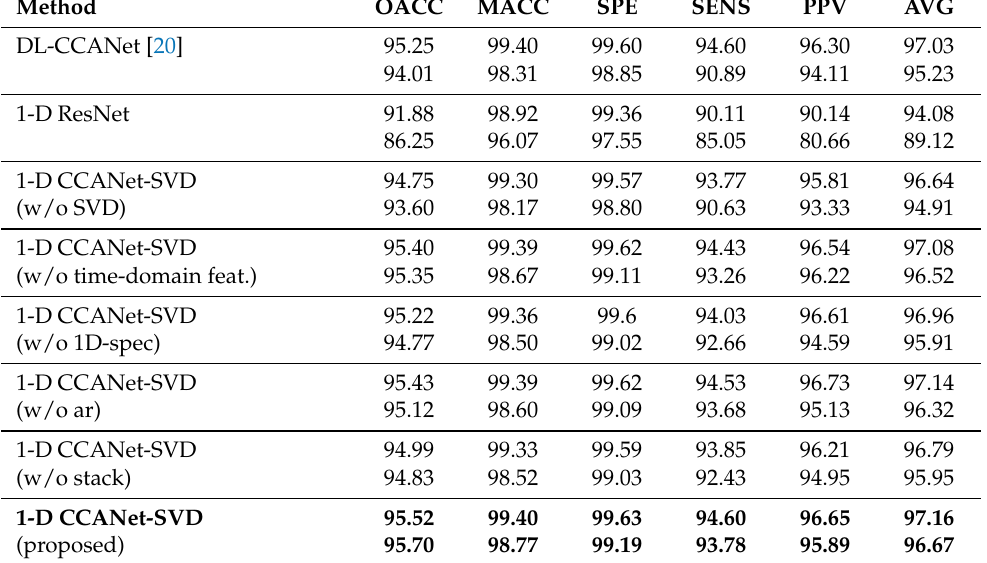
Table 6. Results for various methods (%). For each method, first line reports results for the MIT-BIH database while the second line reports for the INCART database. OACC stands for Overall Accuracy; MACC for Mean Accuracy; SPE for Specificity; SENS for Sensitivity; PPV for Positive Predictive Values; AVG is the Average of the first 5 columns of the table. Best results are highlighted in boldface.